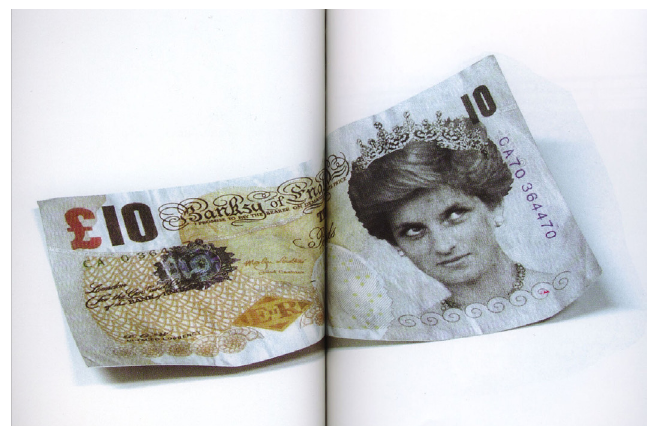
Fig. 4 Banksy, Di-Faced Tenner (Banksy, 2004, pp. 62, 63).